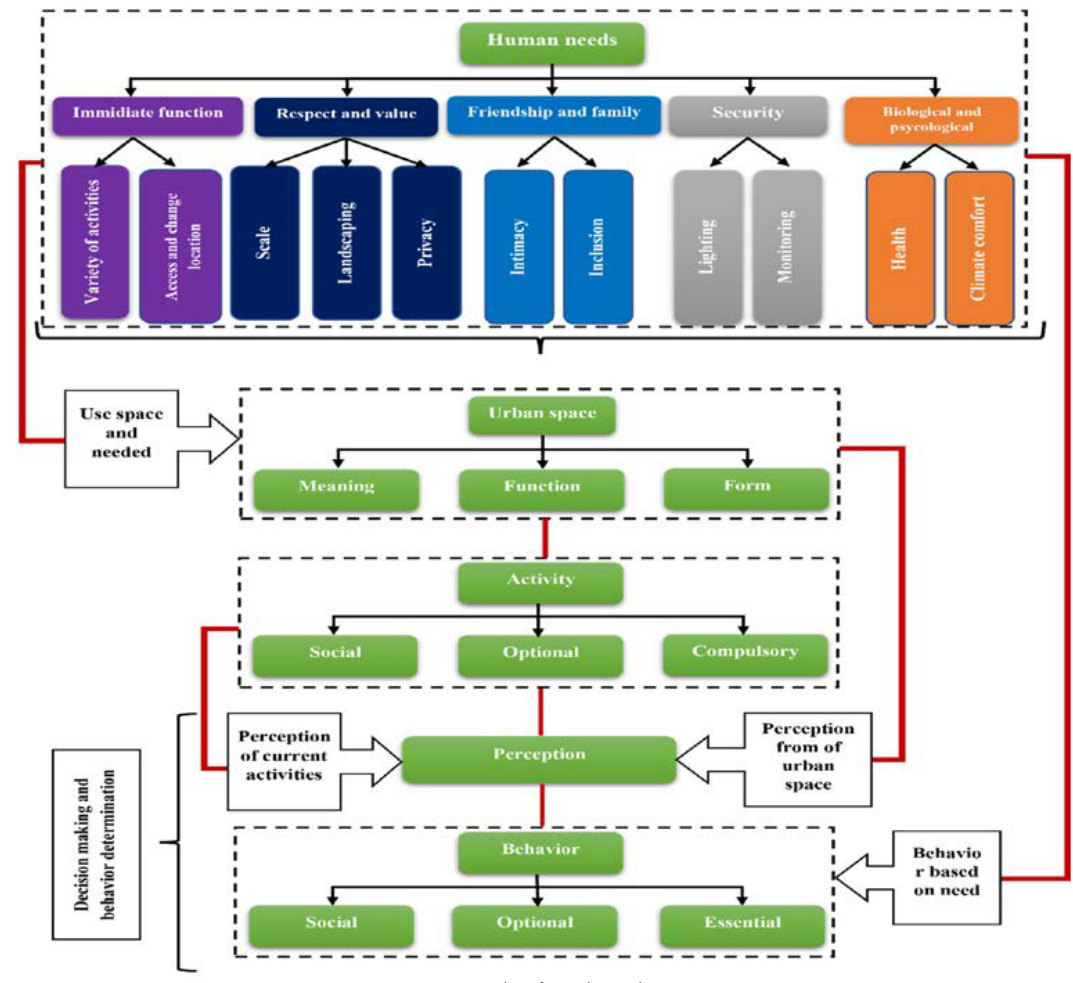
Fig . 3: Hierarchy of Need to Fig. 3: Hierarchy of Need to Behavior